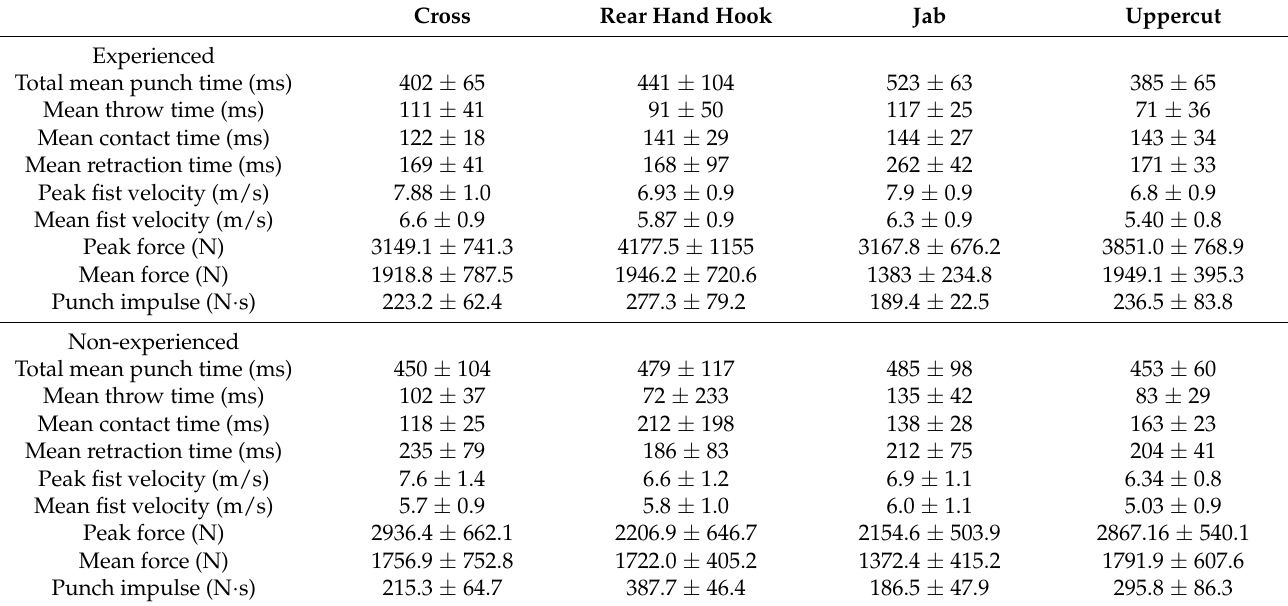
Table 6. Punch variables of the four tested punching techniques. Cross Rear Hand Hook Jab